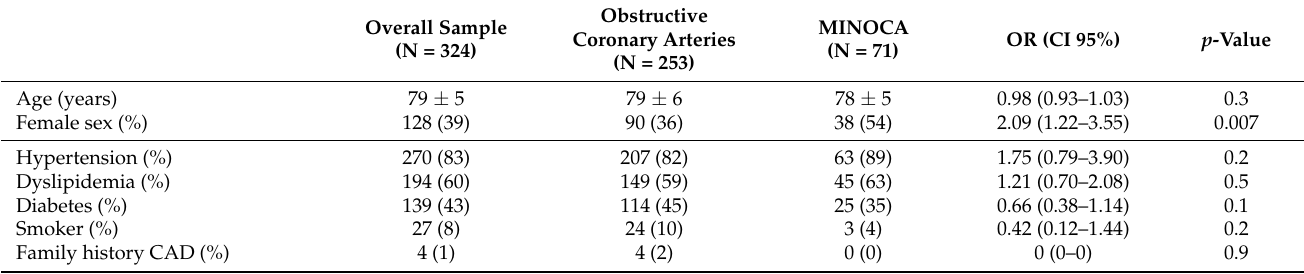
Table 1. Clinical variables. Univariate analysis: association with MINOCA